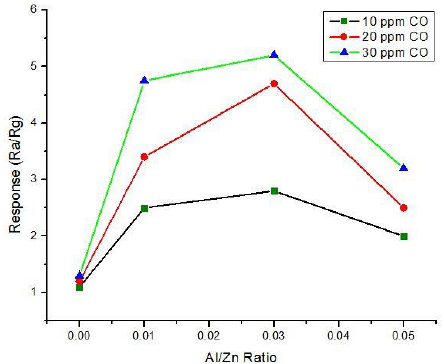
Figure 17. Response according to Al/Zn ratio towards 10, 20 and 50 ppm CO gas at 300 °C.